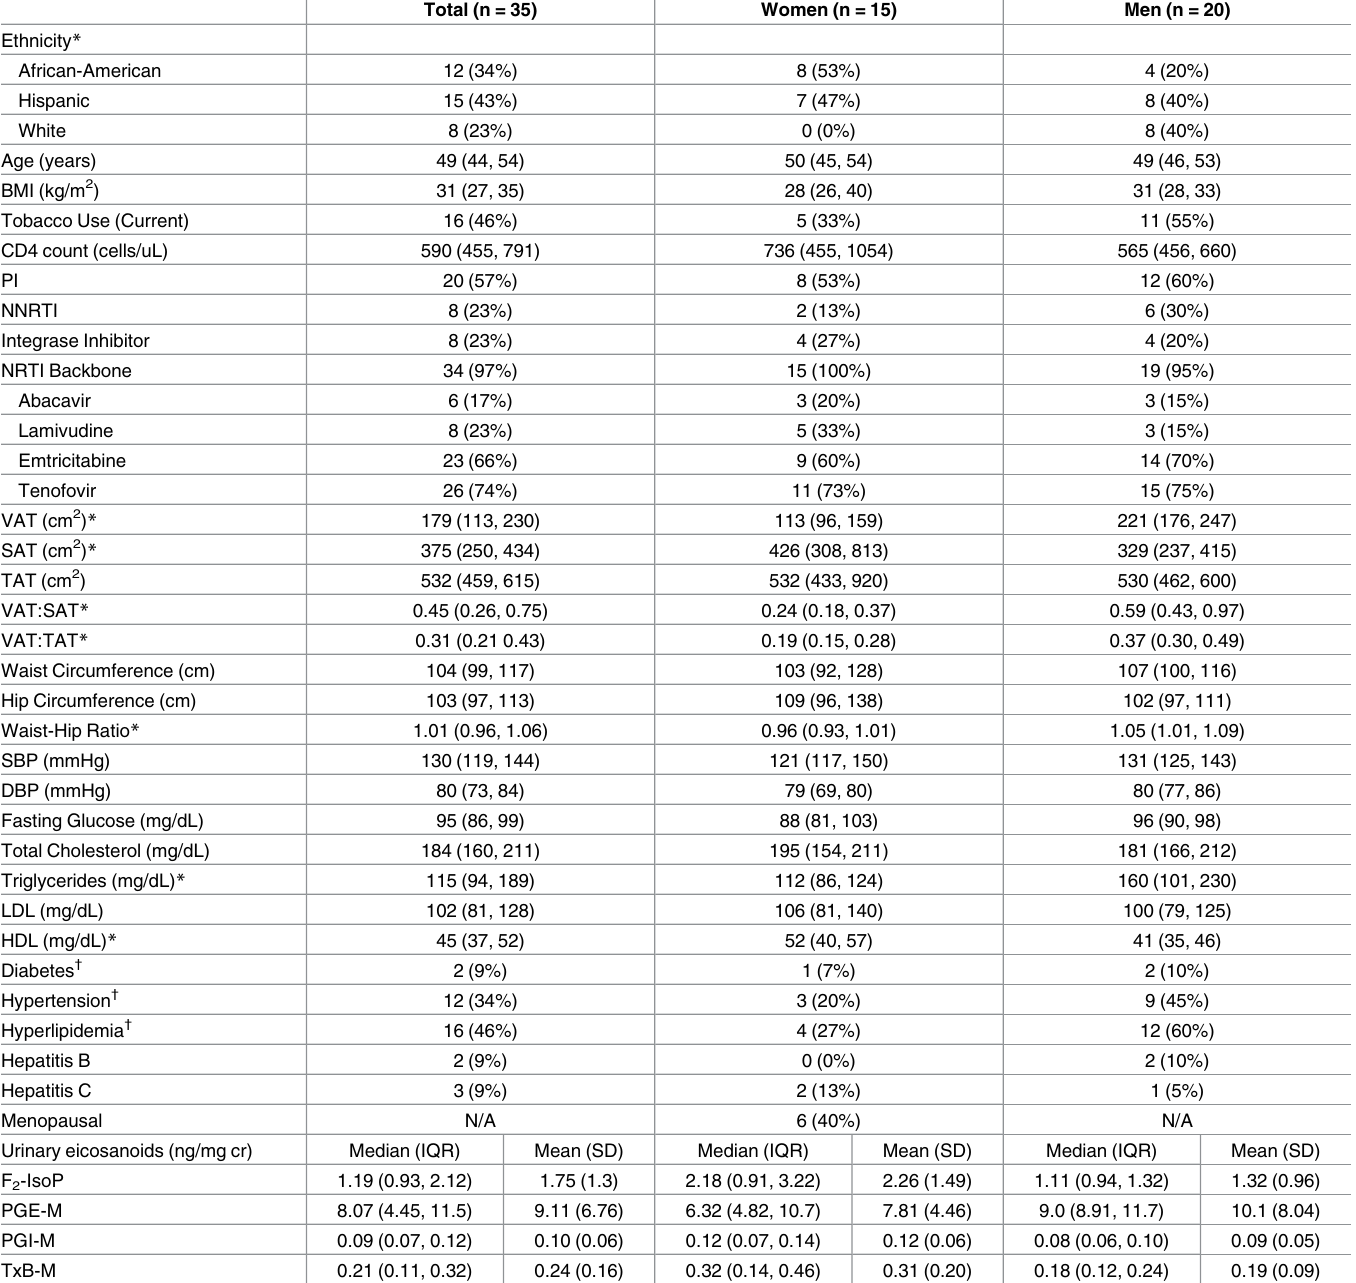
Table 1. Demographic and Clinical Baseline Characteristics §